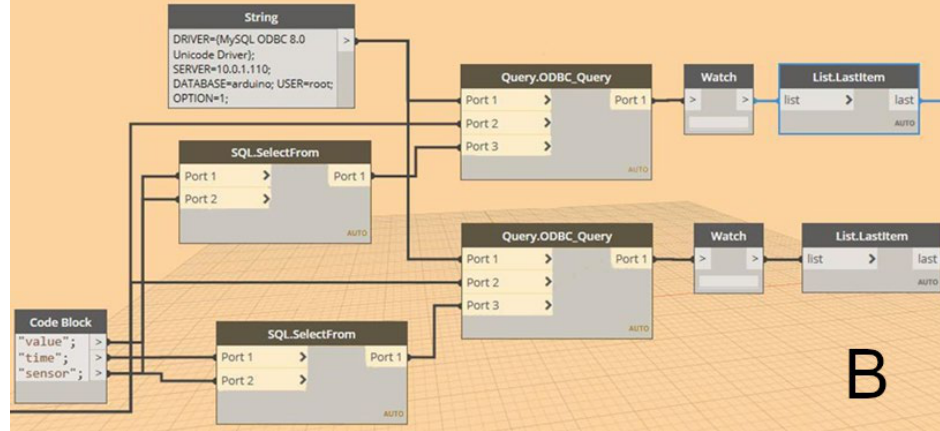
Figure 5. MySQL ODBC connection nodes.